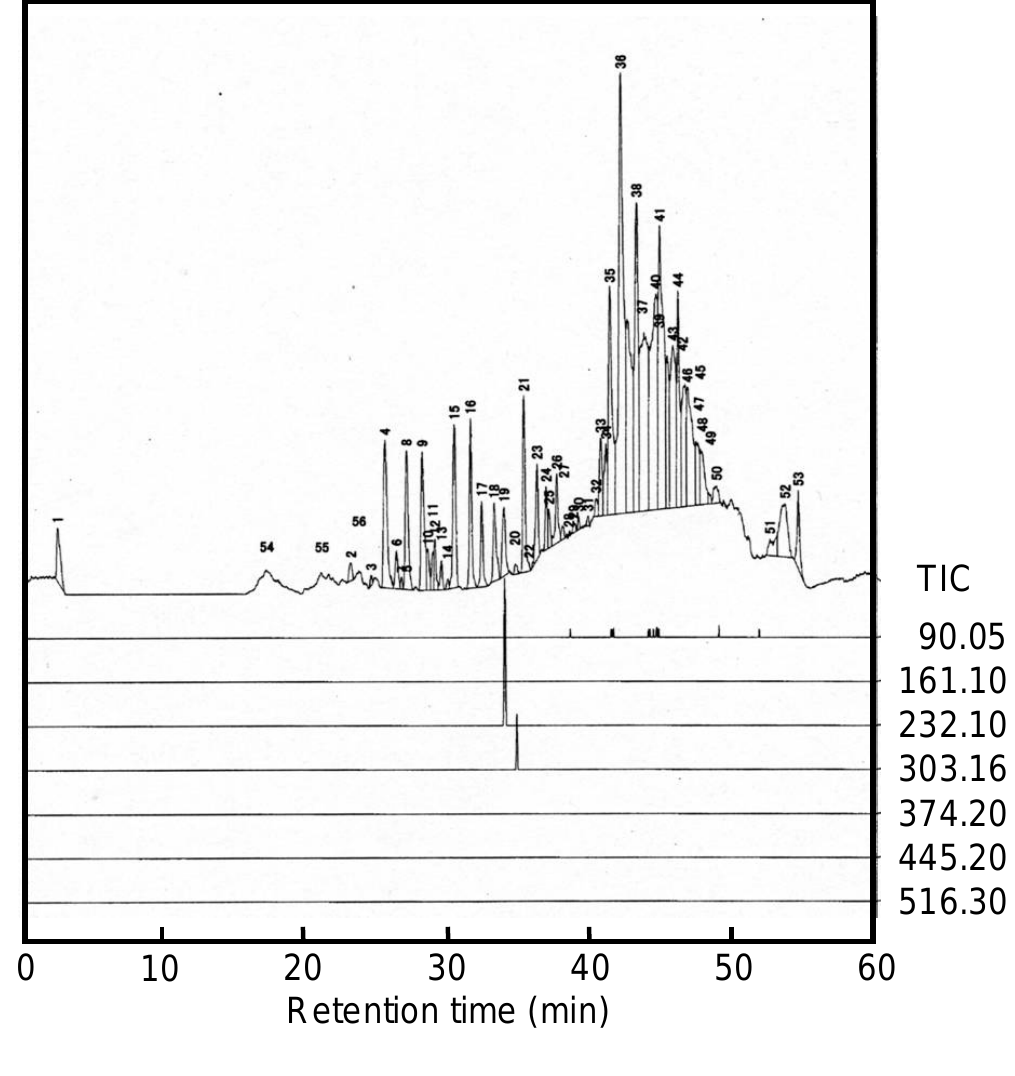
Figure 2. Total ion chromatogram (TIC) and MS chromatograms of alanine monomer and